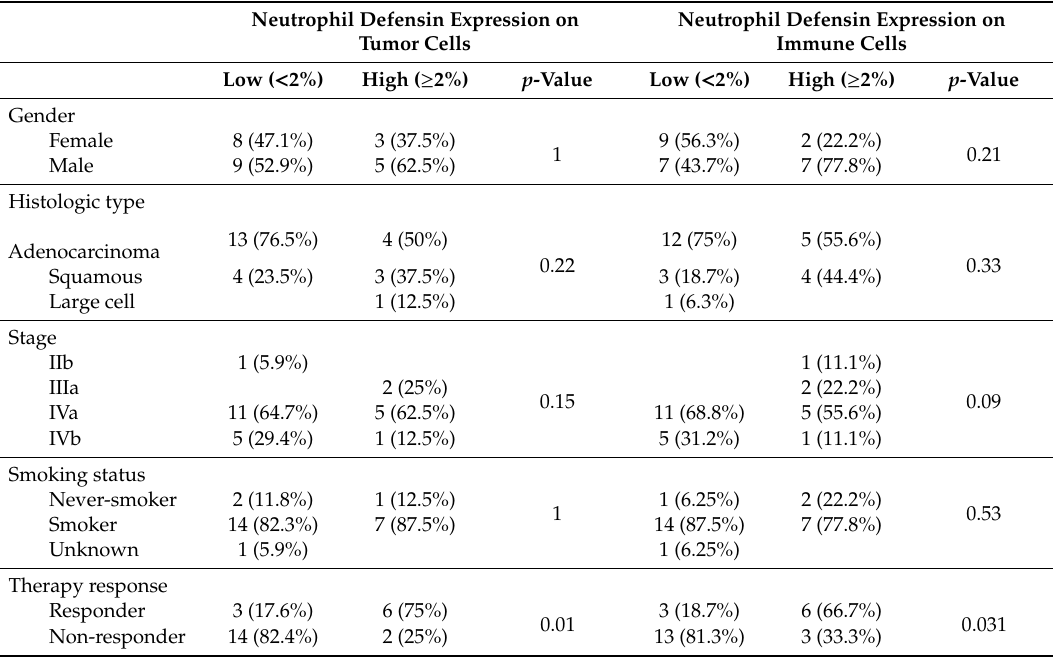
Table 2. Association of neutrophil defensin 1 / 3 expression with clinicopathological